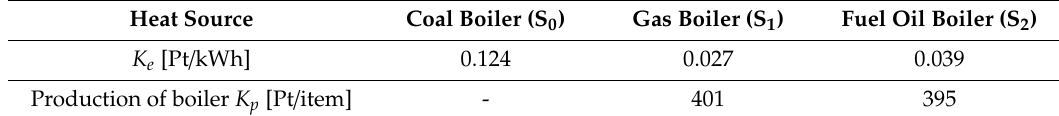
Table 4. The result of LCA analysis of heat production and boilers.